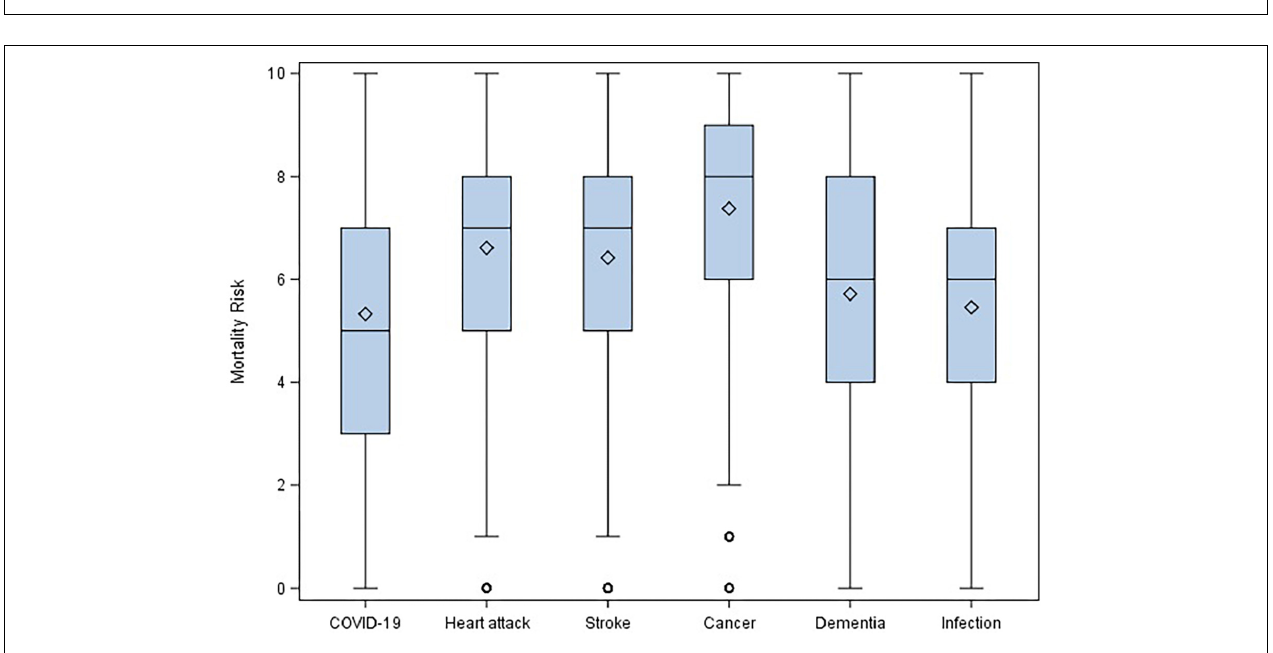
FIGURE 2 | Repeated-measures ANOVA on mortality risk.